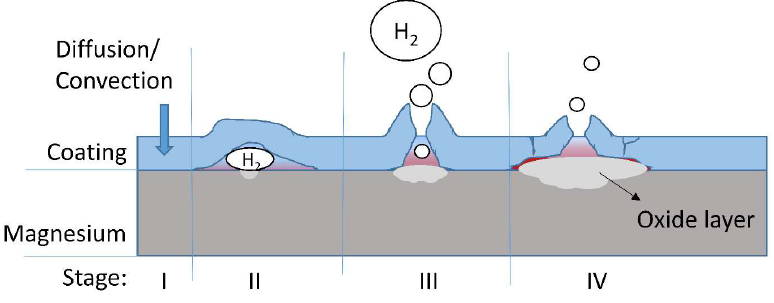
Figure 10. Schematic representation of the interaction of dense coating with magnesium corrosion. The fluid reaches the magnesium surface (Stage I), a hydrogen bubble forms due to magnesium reacting with the fluid (Stage II), the coating breaks open (Stage III), and accumulation leads to oxide layer formation and passivation (Stage IV).